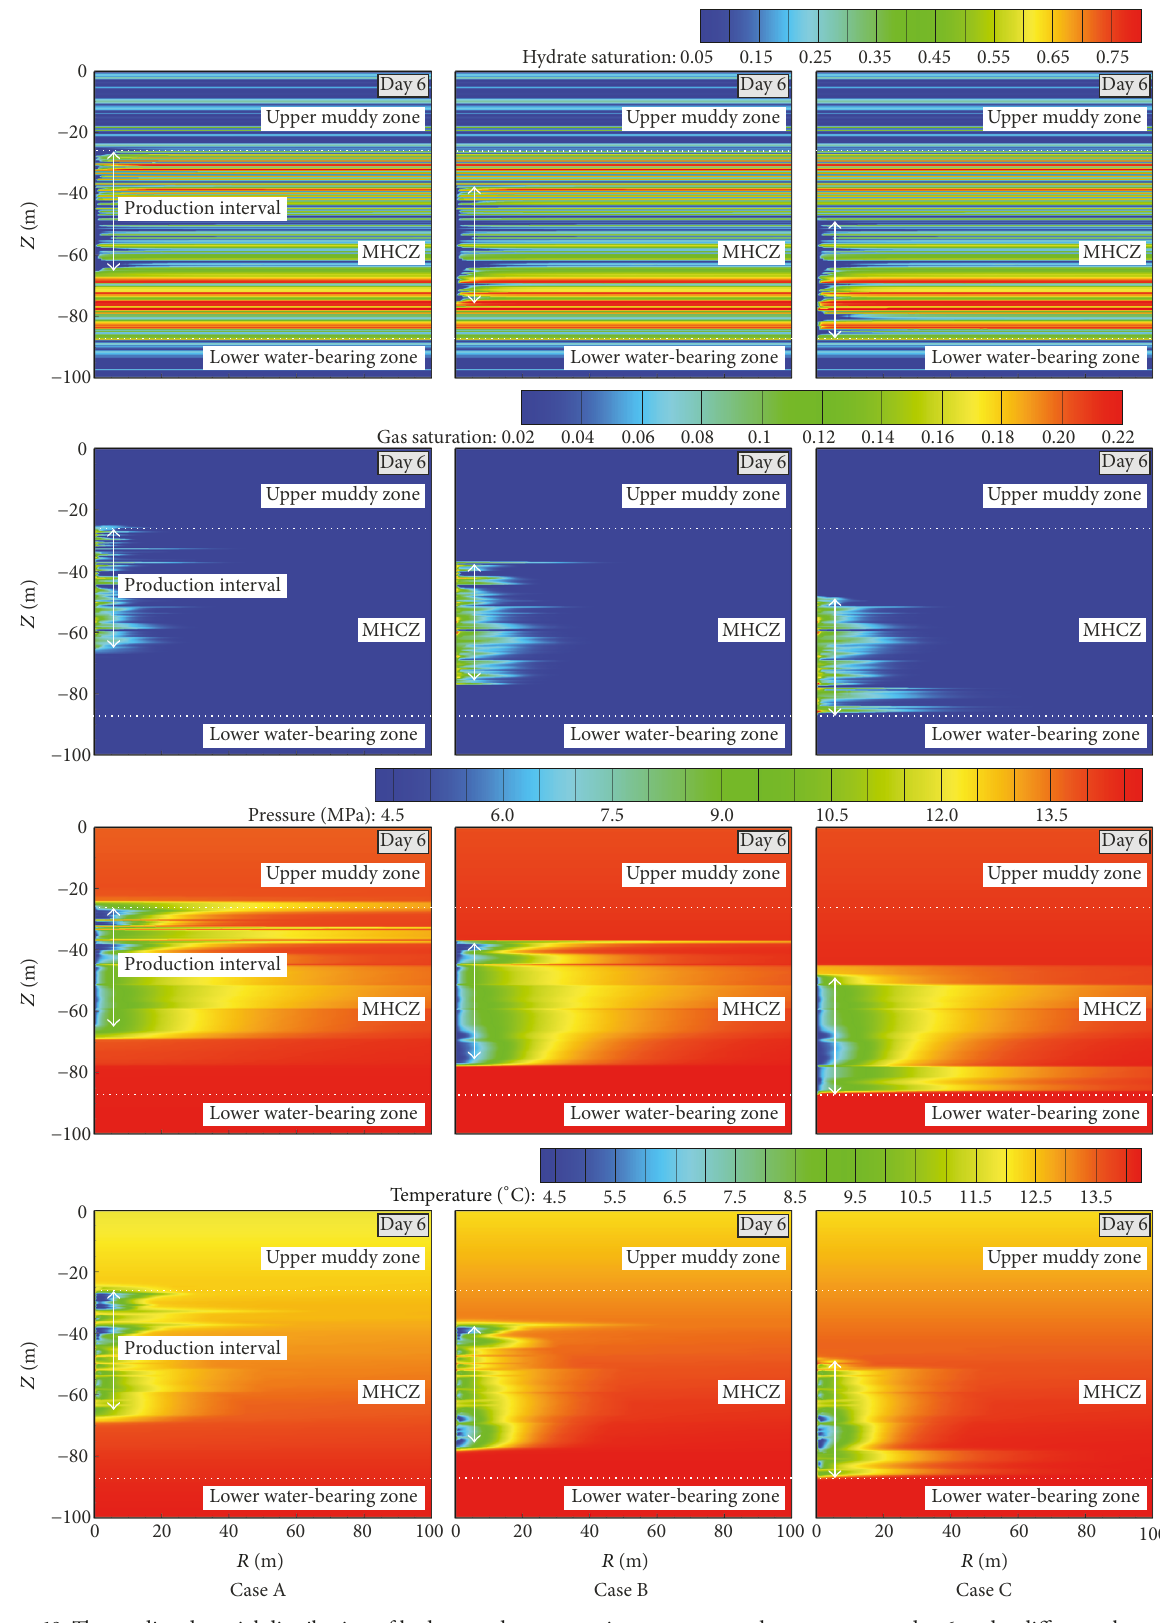
Figure 19: The predicted spatial distribution of hydrate and gas saturation, pressure, and temperature at day 6 under different placement of production